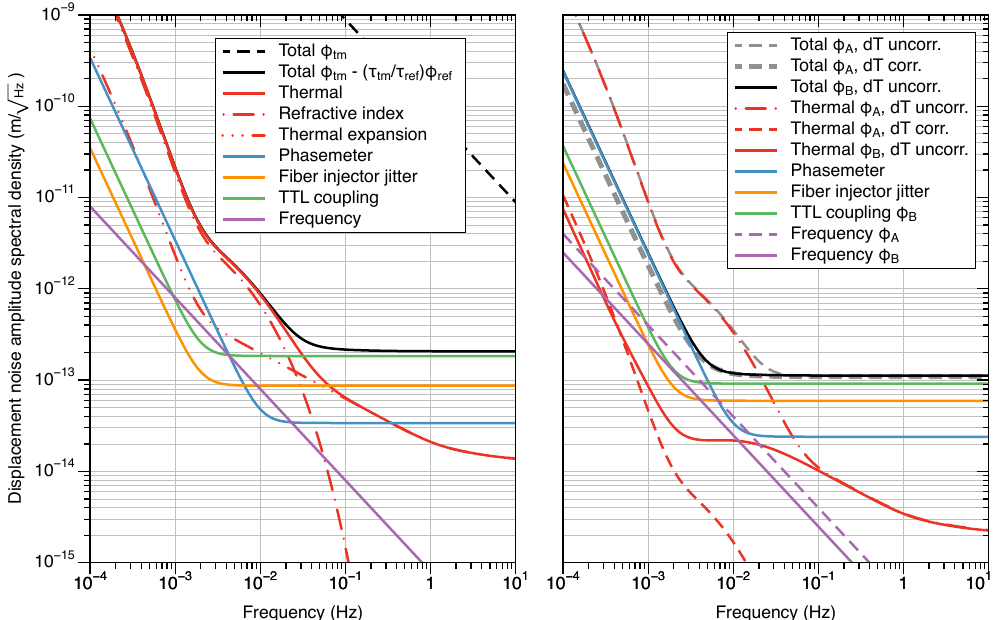
Figure 7. Simulated performance of the SEDI inertial sensor using a single optical head ( left ), and two optical heads probing one test mass from opposite sides ( right ), in which the phase signals are written as a function of the correlation between temperature fluctuations in the two setups. These figures include characteristic imperfections of the manufactured prisms, and an absolute ranging error of 1um affecting the calibration factor. In the setup with two optical heads, two different calibrations are shown: φ A and φ B (see Equations (14) and (17), respectively), for distinct cases in which the interferometer temperature fluctuations are correlated or uncorrelated between the two optical heads used ( dT